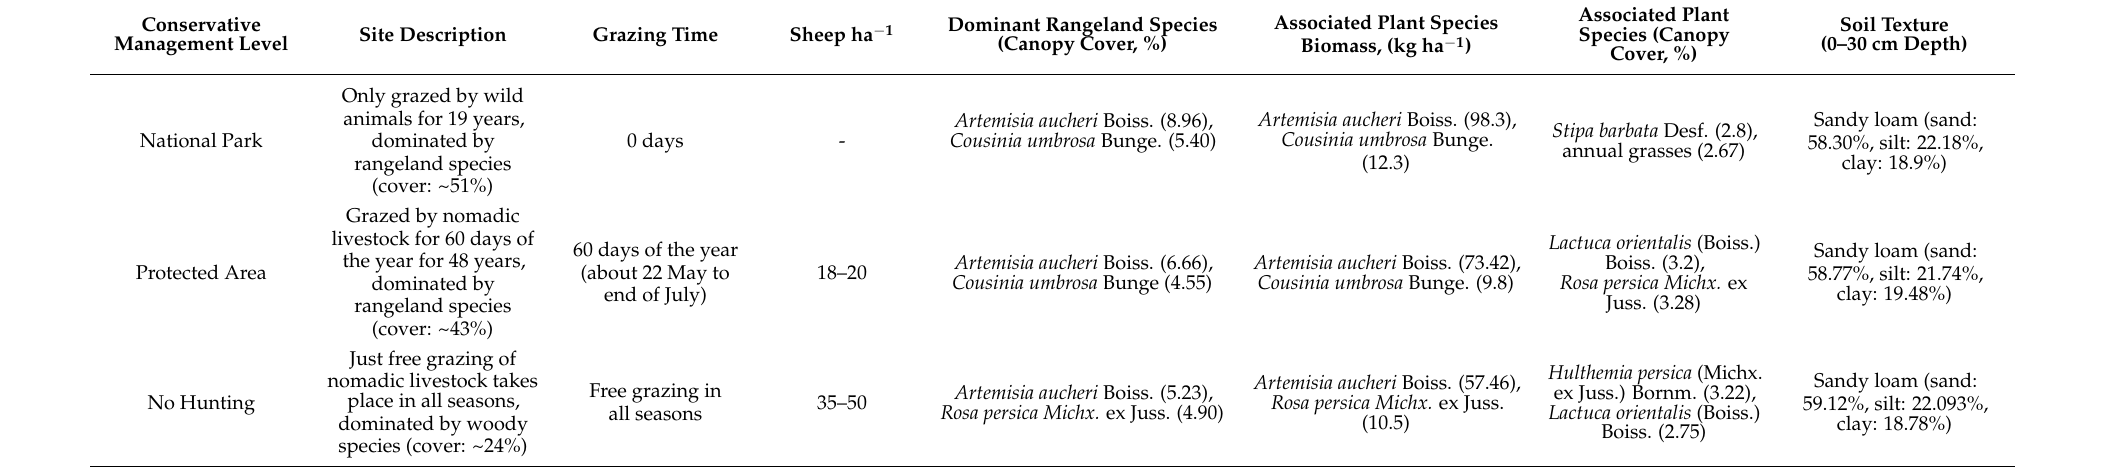
Table 1. General characteristics of the study